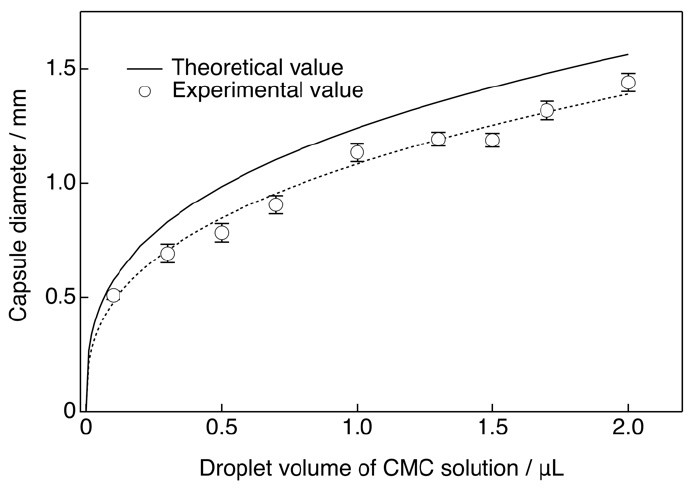
Figure 2. Microscopy images of chitosan–GPTMS–CMC capsules. ( a ) Ch, ( b ) ChG1, and ( c ) ChG2.